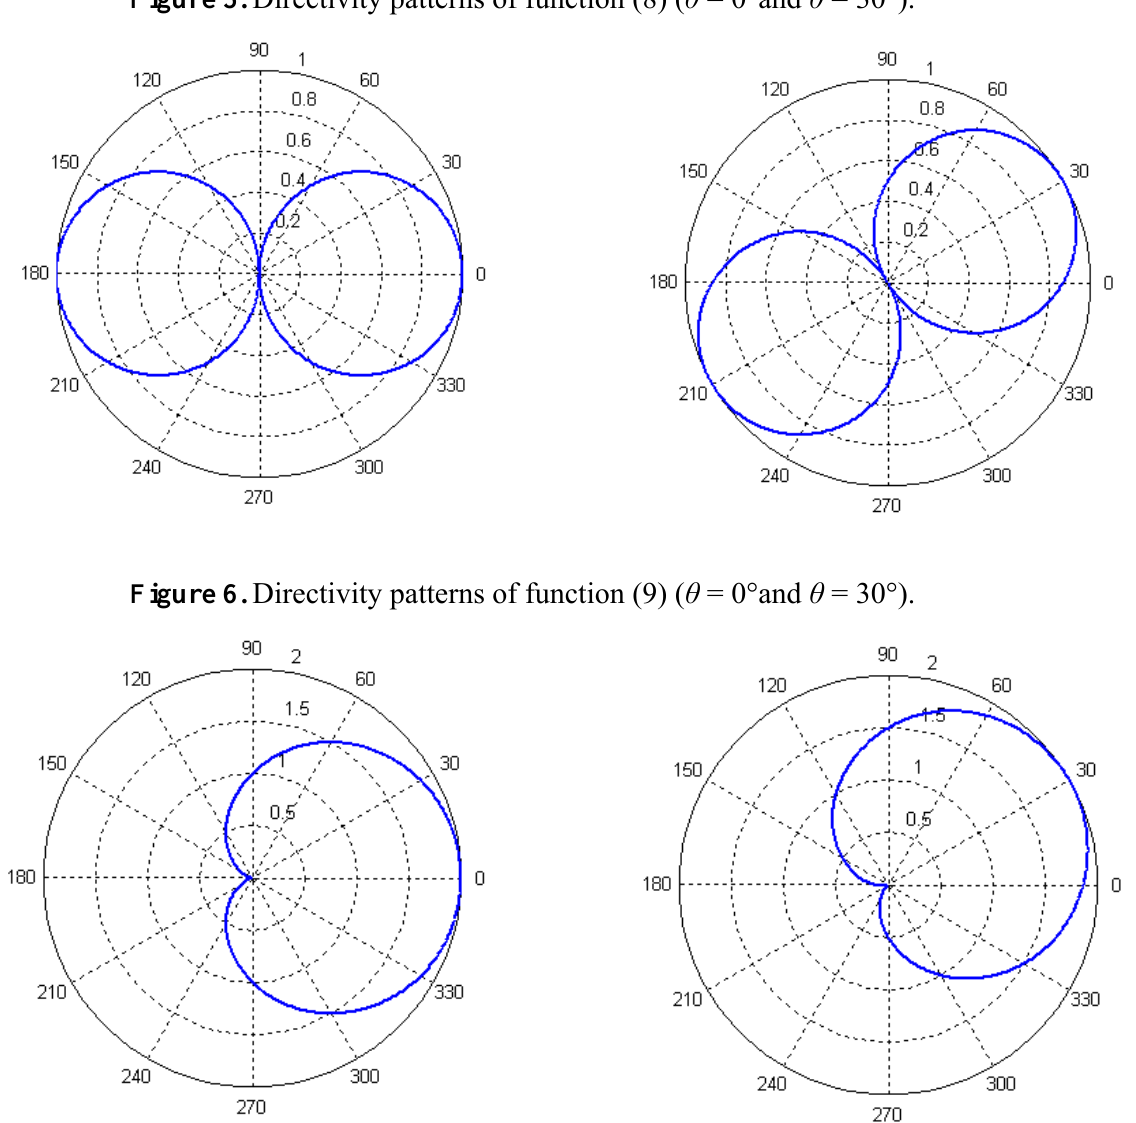
Figure 5. Directivity patterns of function (8) ( θ = 0°and θ = 30°).